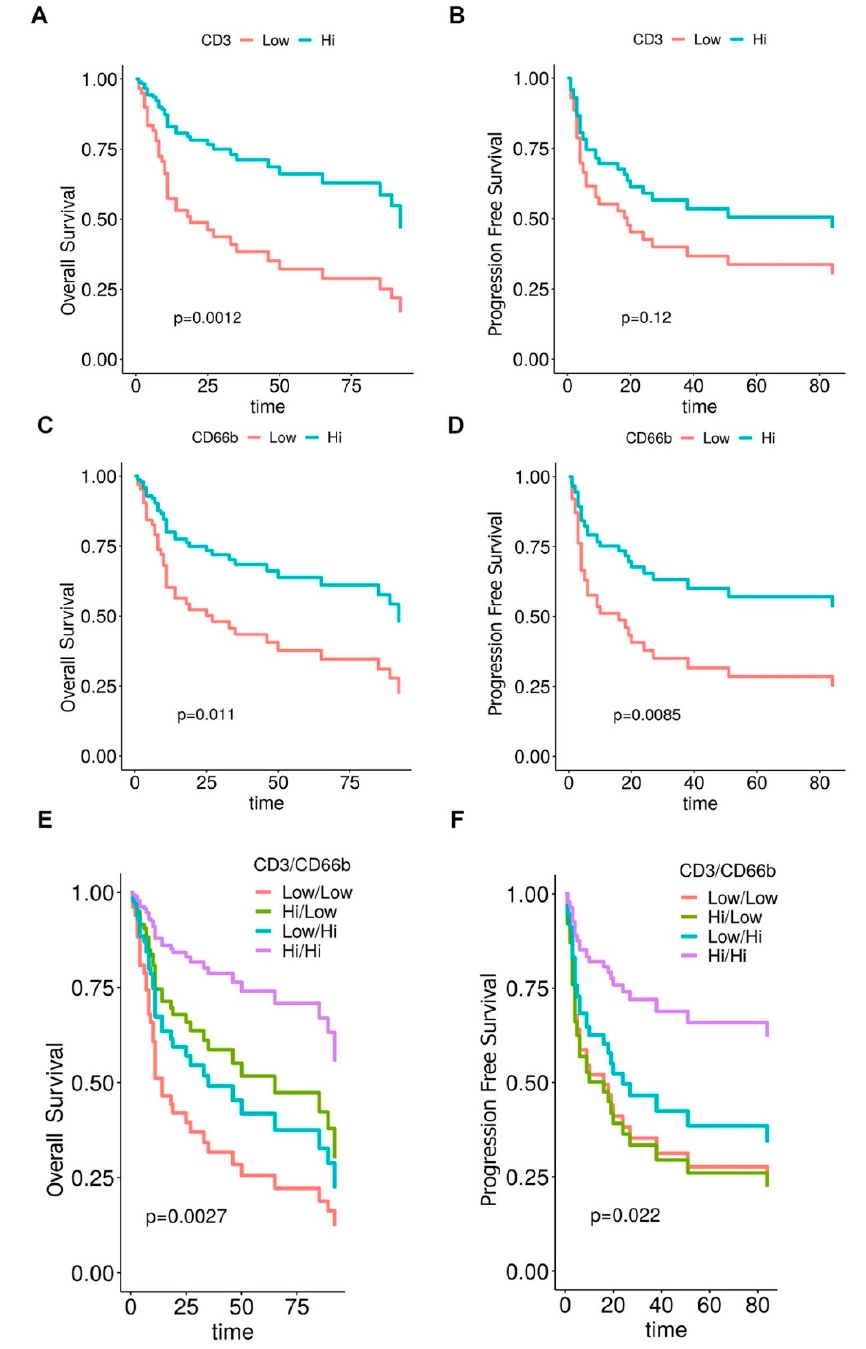
Figure 4. Clinical significance of CD66b + TAN and CD3 + T cells in human MIBC. Kaplan-Meier curves illustrate the overall ( A , C and E ) and progression-free ( B , D and F ) survival in the MIBC cohort. p values are estimated by log-rank test and weighted for pT category (pT2/pT3-4).